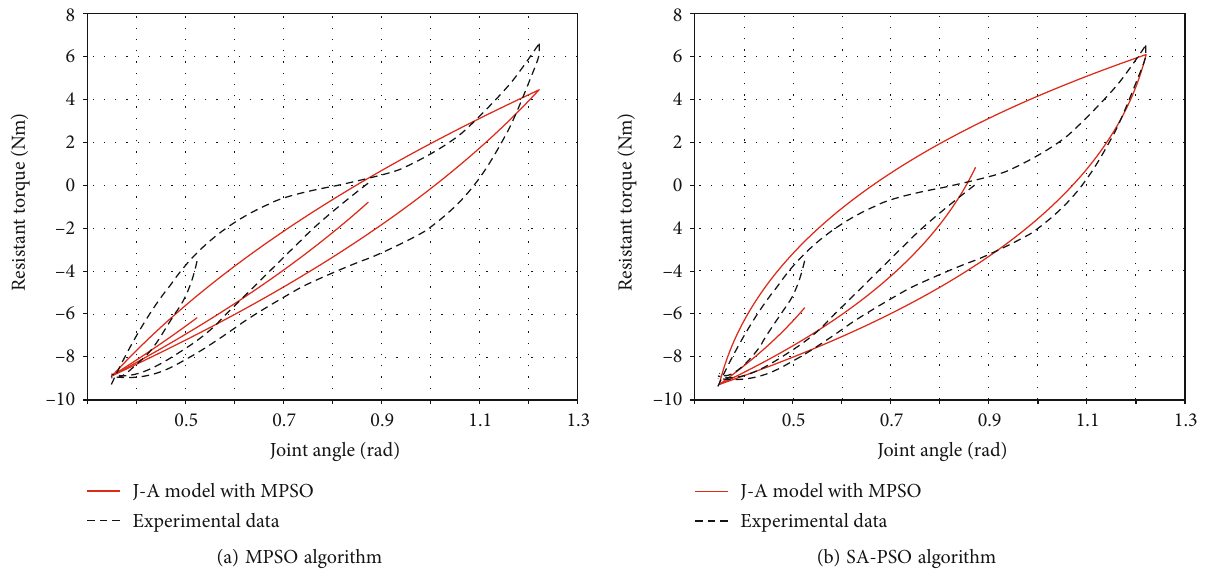
Figure 5: Comparison of resistant torque between shoulder joints ’ experimental data and the J-A model with di ff erent PSO algorithms.